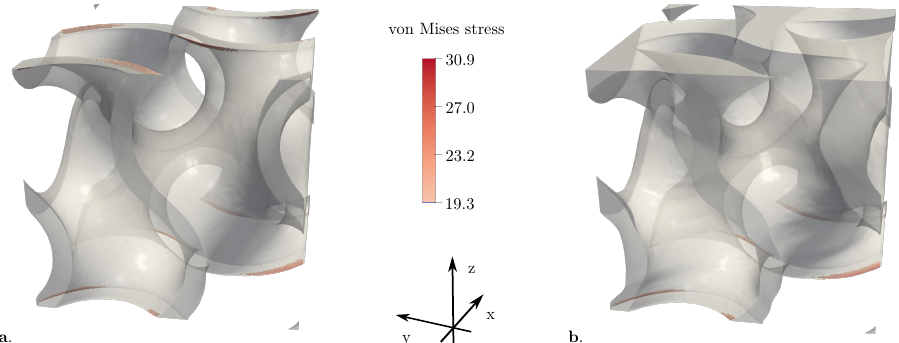
Figure 9. Maximum stresses on the surface of the gyroid structure with ( a ) a constant porosity of 0.8; ( b ) a quadratic porosity function between 0.4 and